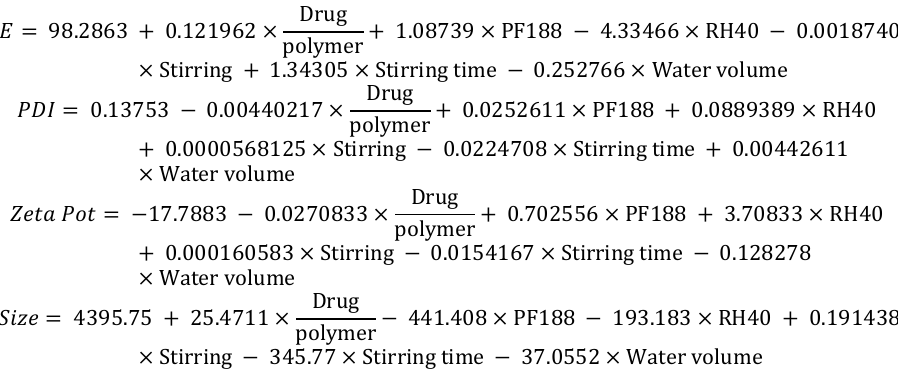
Figure 4. Application of treatments and determination of blood glucose levels.